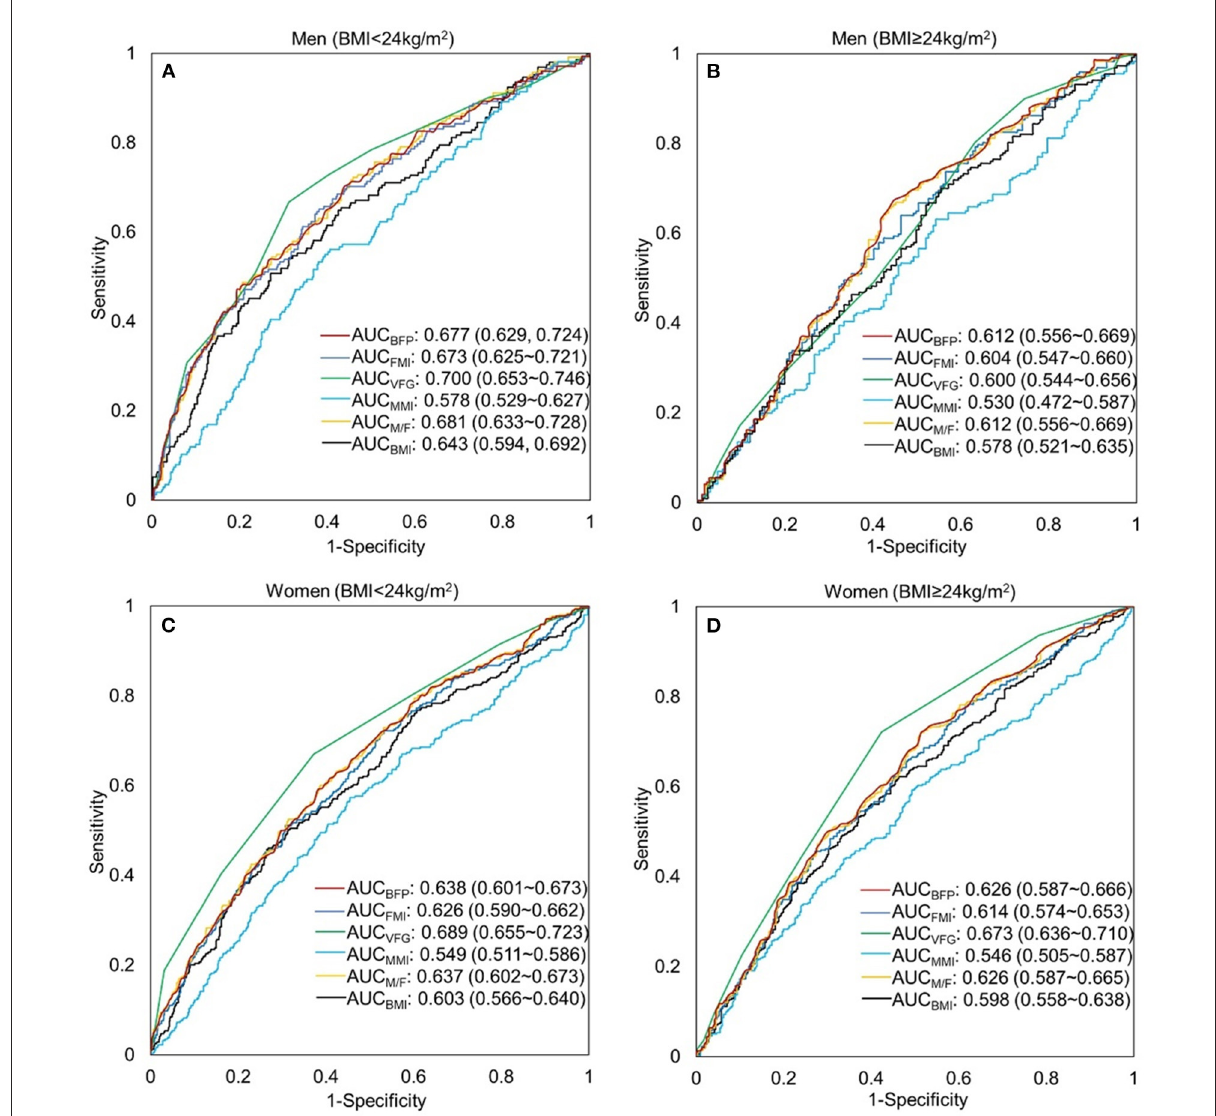
FIGURE4 Receiver-operating characteristic (ROC) curve of the body composition indicators to predict metabolically unhealthy phenotype by sex and BMI. (A) men, BMI < 24 kg/m 2 ; (B) men, BMI ≥ 24 kg/m 2 ; (C) women, BMI < 24 kg/m 2 ; (D) women, BMI ≥ 24 kg/m 2 . BFP, body fat percentage (%); FMI, fat mass index (kg/m 2 ); VFG, visceral fat grade; MMI, muscle mass index (kg/m 2 ); M/F, muscle-to-fat ratio; BMI, body mass index (kg/m 2